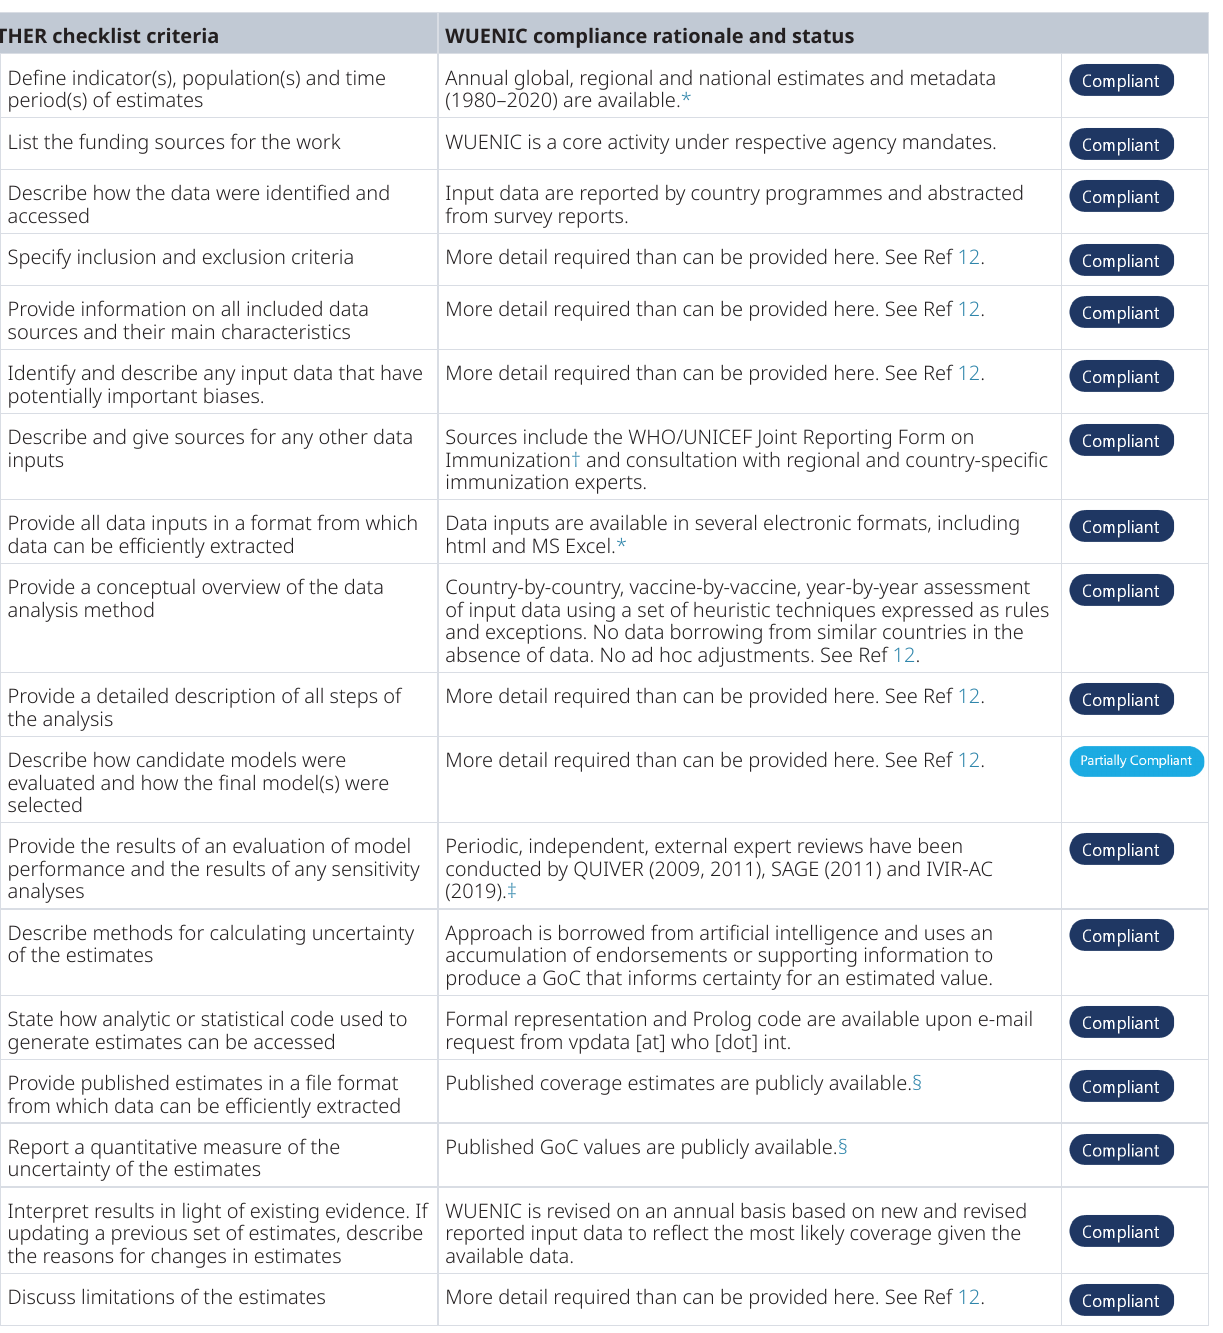
Table 1. GATHER checklist criteria and WUENIC compliance